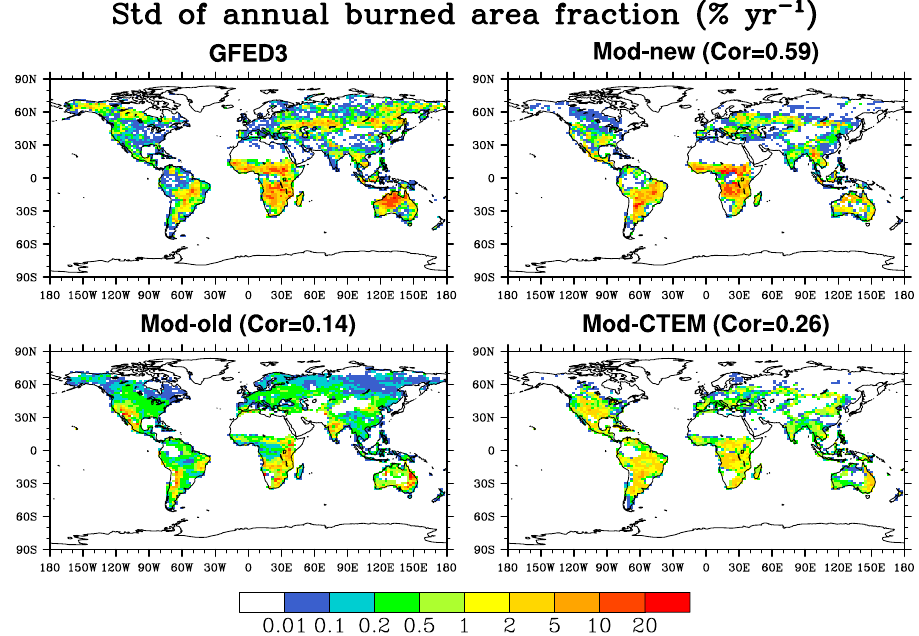
Fig. 12. Same as Fig. 9, but for standard deviation (Std) of annual burned area fraction, which is used as a spatially explicit measure of fire interannual variability.